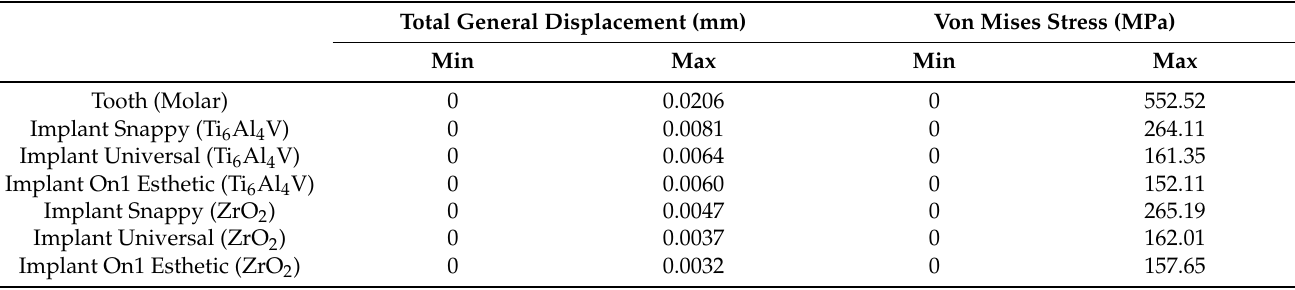
Table 3. Results obtained from the simulation in each case.